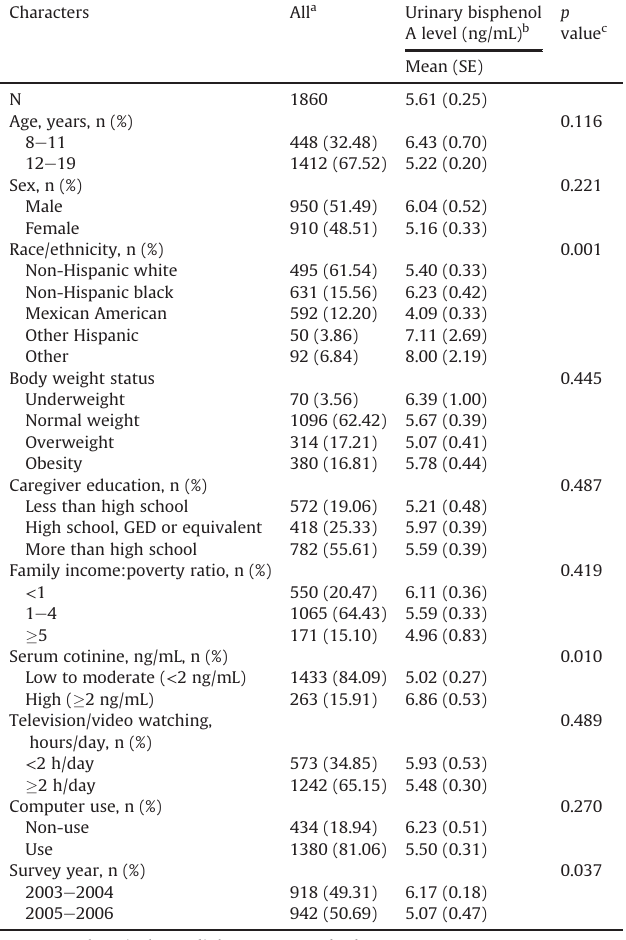
Table 1 Weighted mean urinary bisphenol A concentration of the study participants (8 e 19 years old) by selected demographic characteristics, National Health and Nutrition Examination Survey (NHANES) 2003 e 2006. Characters All a Urinary bisphenol